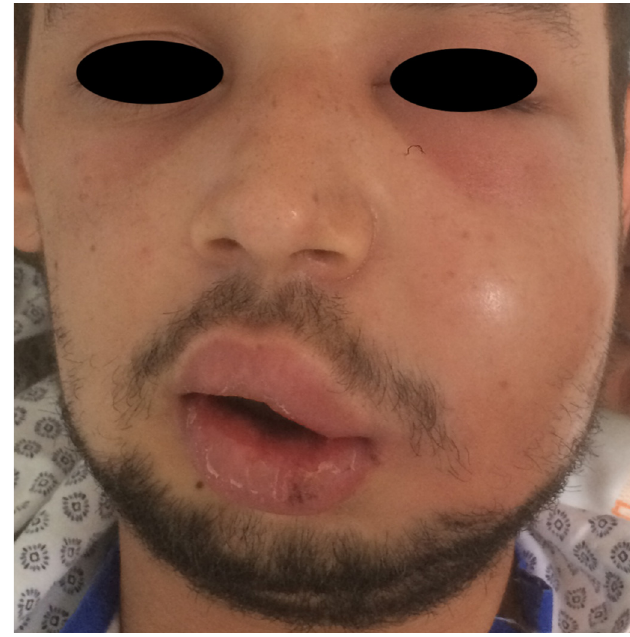
Fig. 3. Clinical fi ndings on postoperative day 3 after the fi rst procedure.